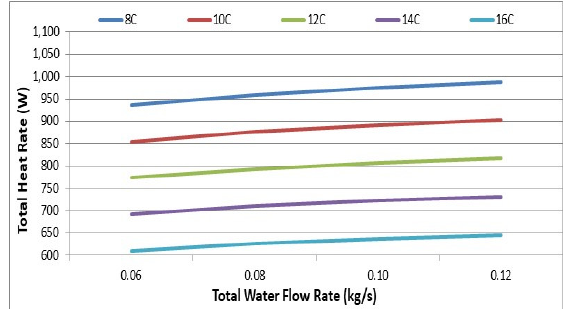
Fig. 4. The total heat rate of terminal units at 8, 10, 12, 14 and 16 °C water supply temperature and valve opening: Valve 1=100%, Valve 2=100% and Valve 3=75%.